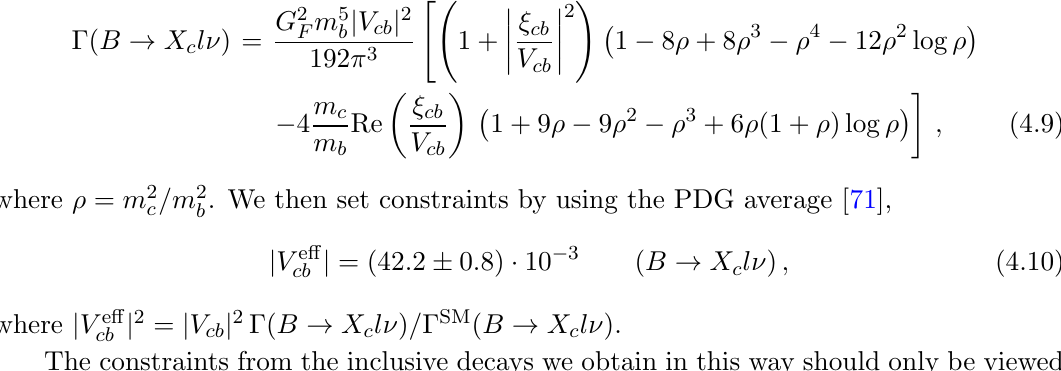
could provide additional l